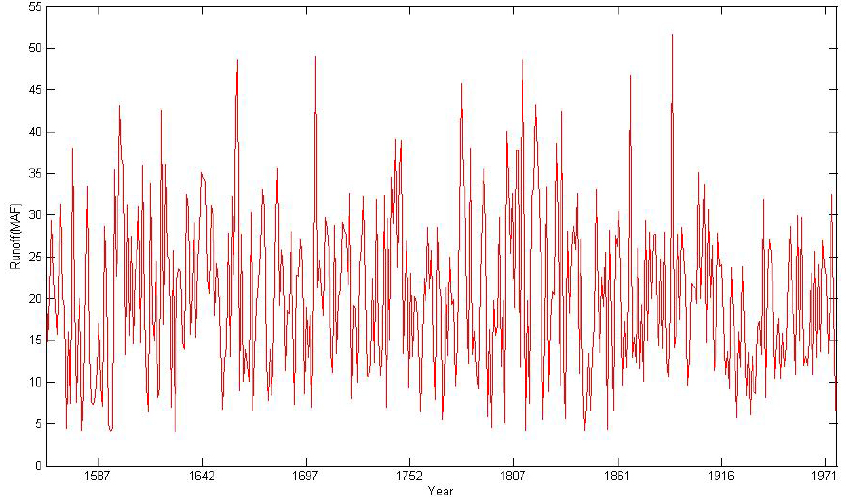
Figure 7. Reconstructed streamflow using the ANN model.